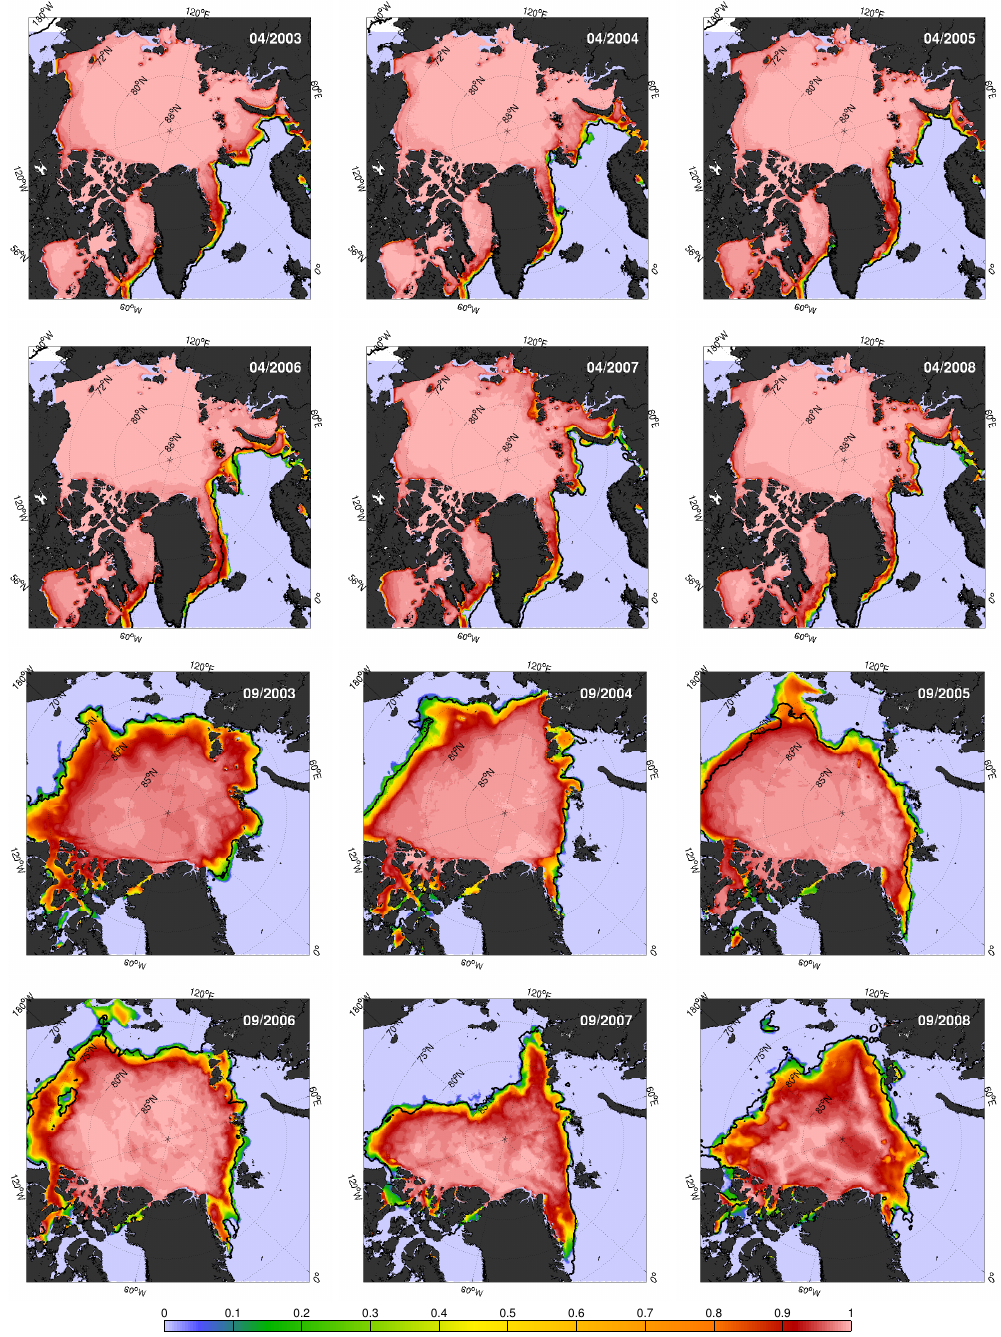
Fig. 12. Monthly average ICEC reanalysis fields for for April (two top rows) and September (two bottom rows). The thick black line shows the 15% concentration contour derived from the monthly average observation based ICEC from